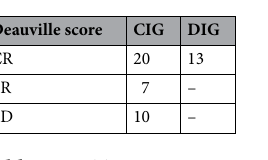
Table 2. EoT response in agreement with PET-based